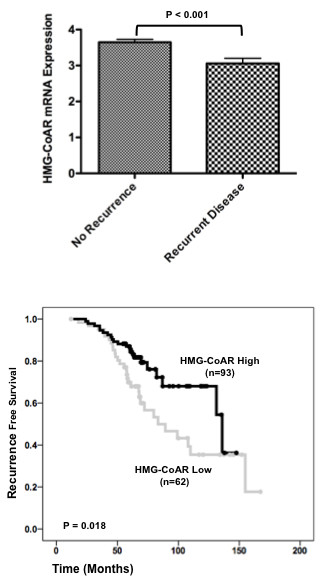
HMG-CoAR mRNA expression is associated with increased recurrence-free survival in tamoxifen-treated breast cancer patients. (a) Mean 3-hydroxy-3-methylglutharyl-coenzyme A reductase (HMG-CoAR) mRNA levels were significantly higher in patients who remained disease-free after tamoxifen treatment. *P < 0.001. (b) Kaplan-Meier using estimates of recurrence-free survival according to HMG-CoAR mRNA expression using mean HMG-CoAR expression as a threshold.